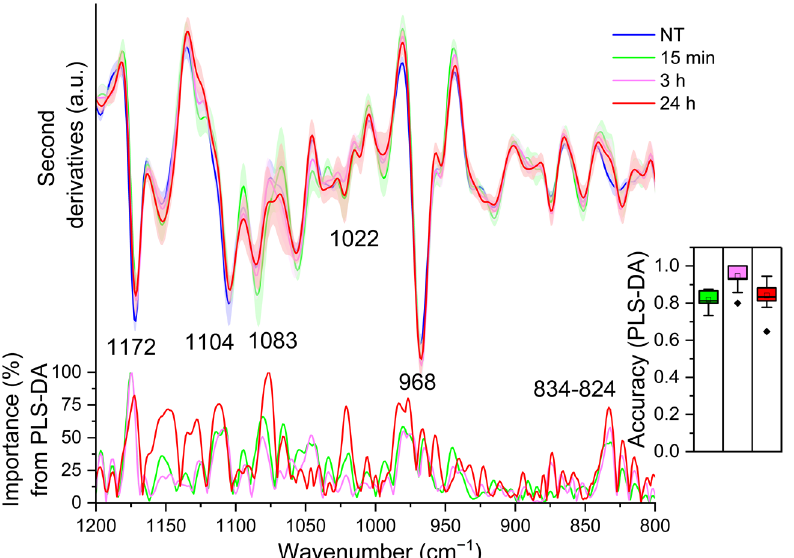
Figure 4. Mean second derivative spectra in the 1200–800 cm − 1 range of TDM cells before (0 h) and at different time points of LPS treatment. Standard deviation has also been displayed as a shadowed area. Below, the wavenumber importance for PLS-DA discrimination performed in the 1200–800 cm − 1 spectral range is shown. The PLS-DA discrimination accuracy has been also reported in the inset. Box plot is given as in Figure 1.